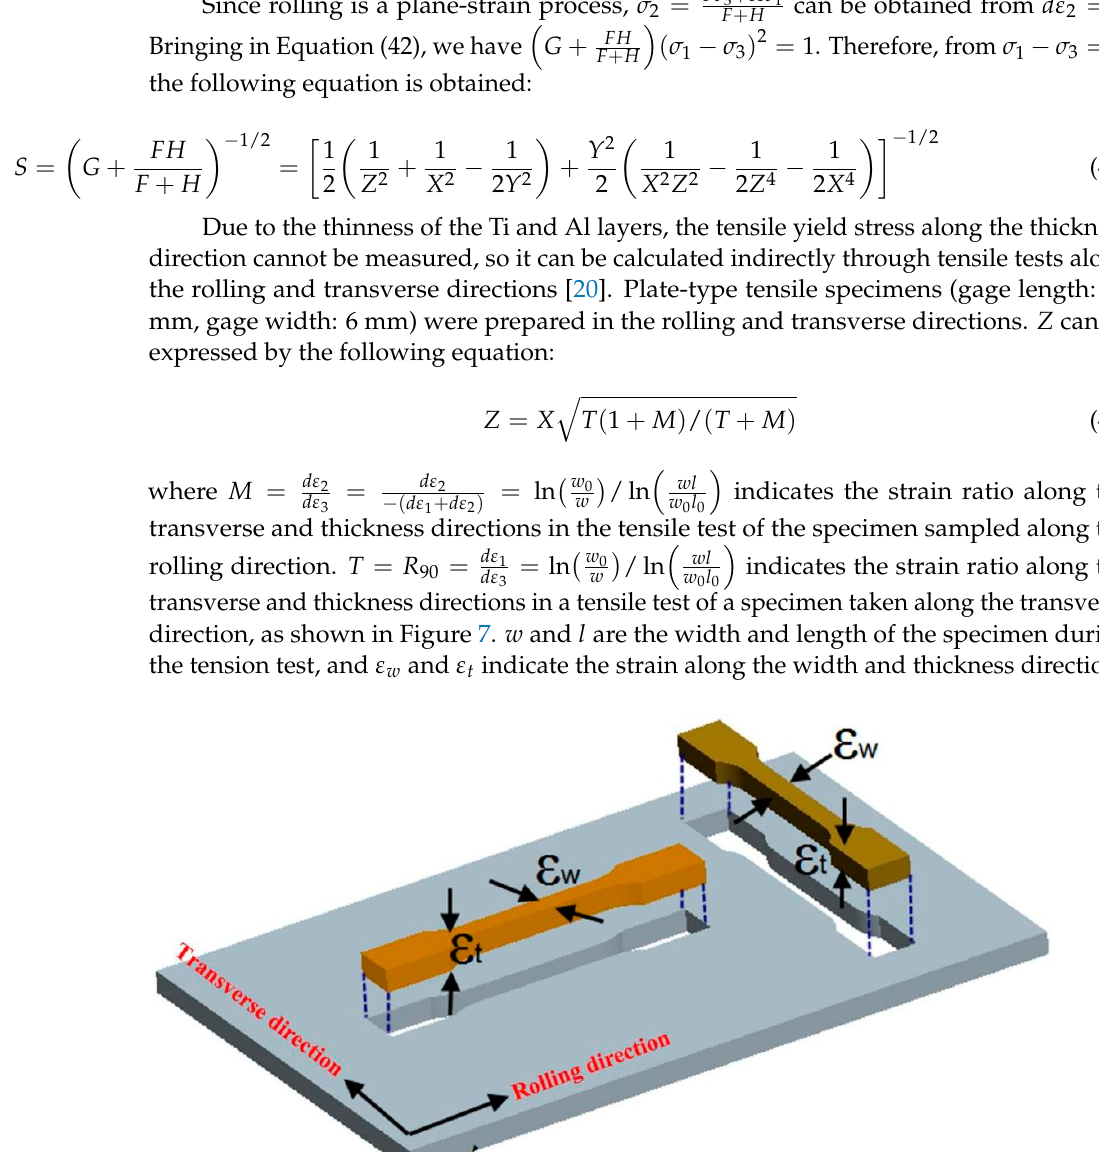
Figure 7. The tensile specimen cut from raw material.